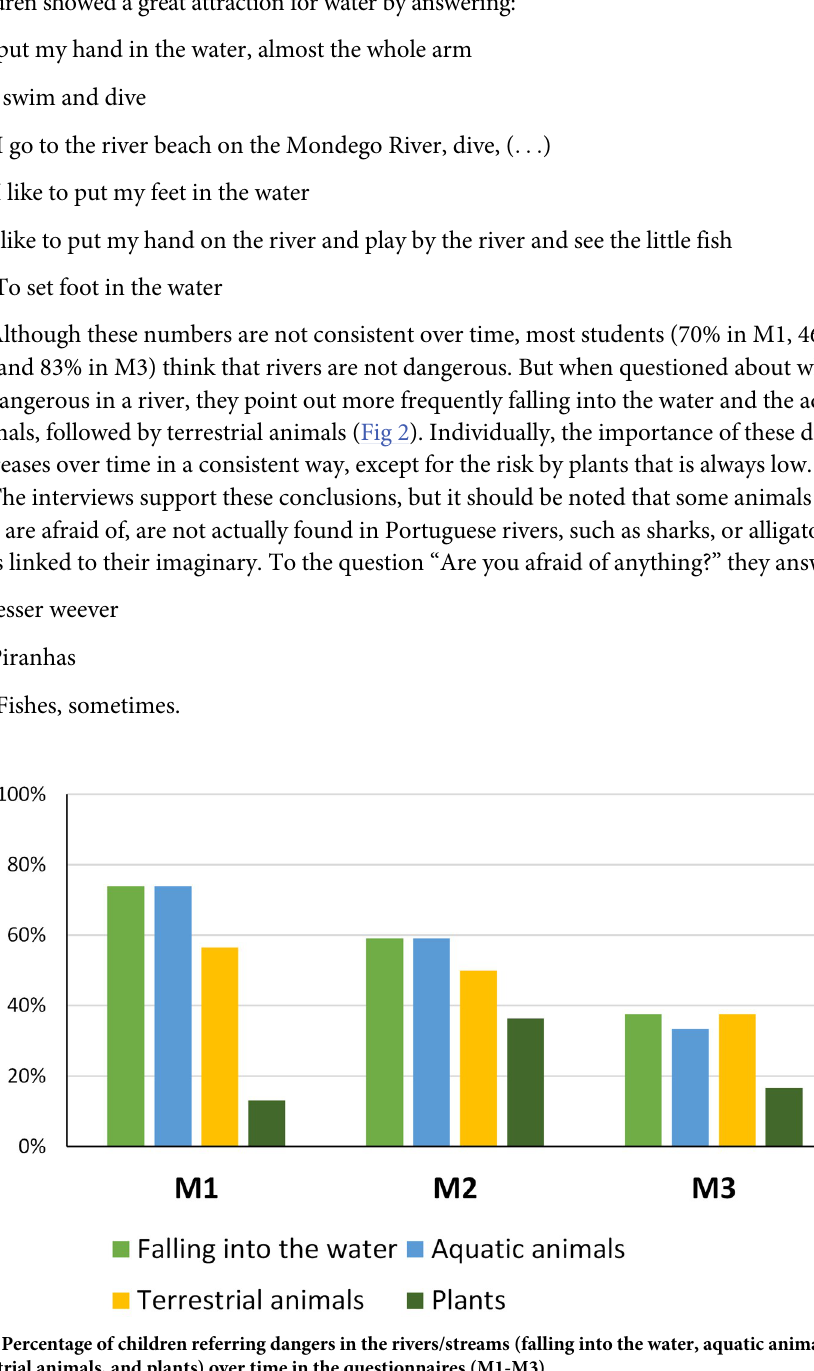
PLOS ONE | https://doi.org/10.1371/journal.pone.0266776 April 27,